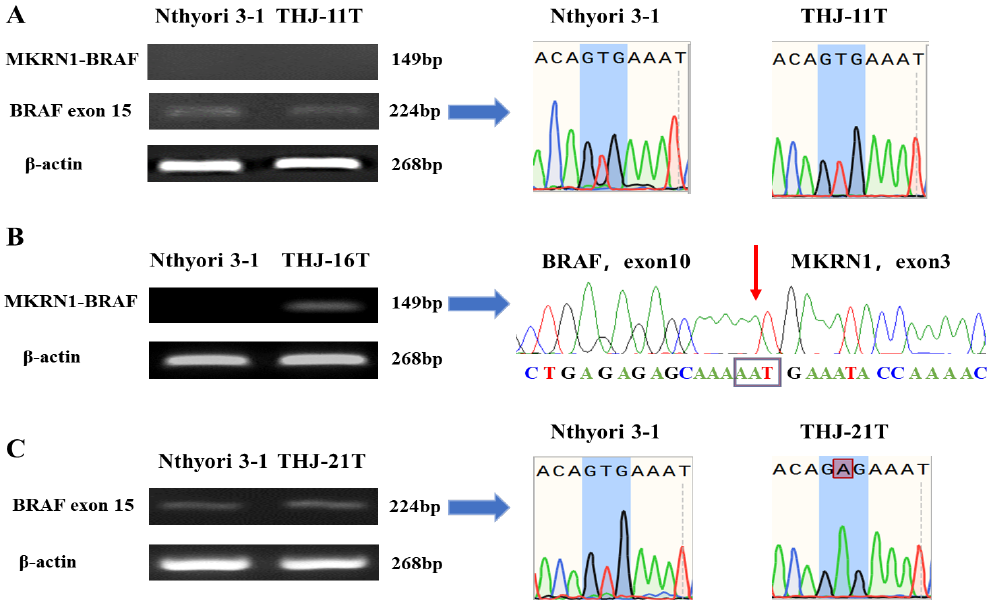
Figure 3. Identification of mutant BRAF expression by reverse transcription – polymerase chain reaction and Sanger sequencing. Reverse transcription – polymerase chain reaction (RT-PCR) detected BRAF exon 15 and MKRN1-BRAF transcripts in ATC cells. Sanger sequencing chromatograph of the BRAF exon 15 and MKRN1 – BRAF fusion in THJ-11T ( A ), THJ-16T ( B ), THJ-21T ( C ), and Nthyori 3-1 cells ( A , C ). The arrow shows the breakpoint of the fusion between MKRN1 (NM_001145125, end of exon 3) and BRAF (NM_004333, start of exon 10). 2.5. Inhibition of Mutant BRAF-MAPK Signaling by Resveratrol and Targeting Drugs The effects of resveratrol on the MAPK pathway in three ATC cell lines were eluci- dated and compared with those of the MAPK pathway-targeted drugs (dabrafenib and trametinib). The results of the Western blotting showed that resveratrol had no effect on the MAPK pathway in THJ-11T cells because of the unchanged pBRAF, pMEK, and pERK levels before and after treatment. The MAPK pathways in THJ-16T and THJ-21T cells were significantly inhibited by the two MAPK pathway-targeted drugs and especially resvera- trol, showing significantly reduced levels of pBRAF, pMEK, and pERK (Figure 5A). The results of immunocytochemical staining were in accordance with the Western blot find- ings in terms of distinct reduction of pERK staining around the nuclear envelope and in the nuclei of THJ-16T and THJ-21T cells treated by resveratrol, dabrafenib/trametinib, and dabrafenib/trametinib in combination with resveratrol. There were no significant changes of pERK levels in THJ-11T cells without and with resveratrol treatment (Figure 5B). 2.6. Enhanced STAT3 Activation by MAPK-Targeting Drugs It has been reported that inhibition of the MAPK pathway activates the JAK2/STAT3 pathway [35], and autocrine Interleukin 6 (IL-6) secretion and subsequent JAK2/ STAT3 activation may represent an unexpected route to overcome targeted inhibition of the MAPK pathway in BRAF mutant cancers [36]. The levels of IL-6, total STAT3, and phos- phorylated STAT3 (pSTAT3) in trametinib-treated THJ-16T and dabrafenib/trametinib- treated THJ-21T cells were checked by immunofluorescent (IF) labeling and/or Western blotting. The IF results showed that both trametinib and the dabrafenib/trametinib com- bination promoted STAT3 phosphorylation in the two cell lines (Figure 6A). In